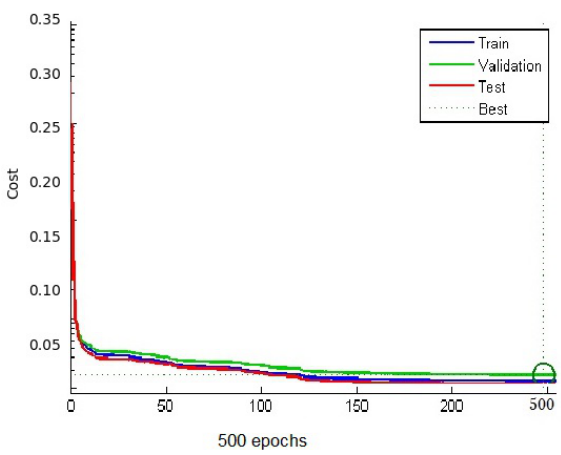
Figure 6. A adapted MLP classifier using Softmax based gradient descent calculation cost and